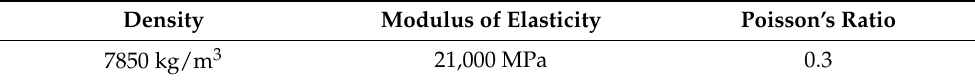
Table 1. Bit parameter